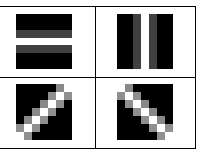
Table 3. One of the autoencoder-related experiments, labeled as MF4 , uses fixed encoder filters (the encoder part of the overall architecture is described in Figure 2). This table presents the predefined values of 7 × 7 convolutional filters, visualized as bitmaps.